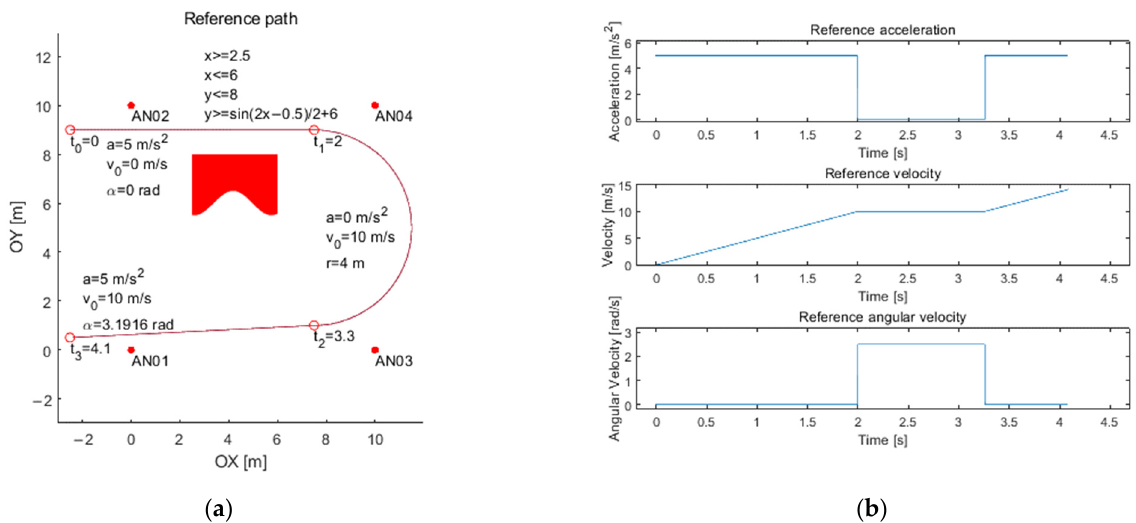
Figure 20. Example of ( a ) path with parameters and ( b ) motion description.